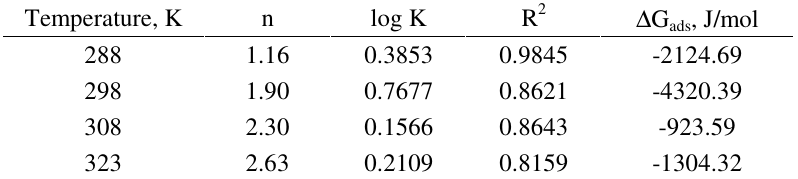
Table 1. Freundlich parameters for the adsorption Zn 2+ onto human hair